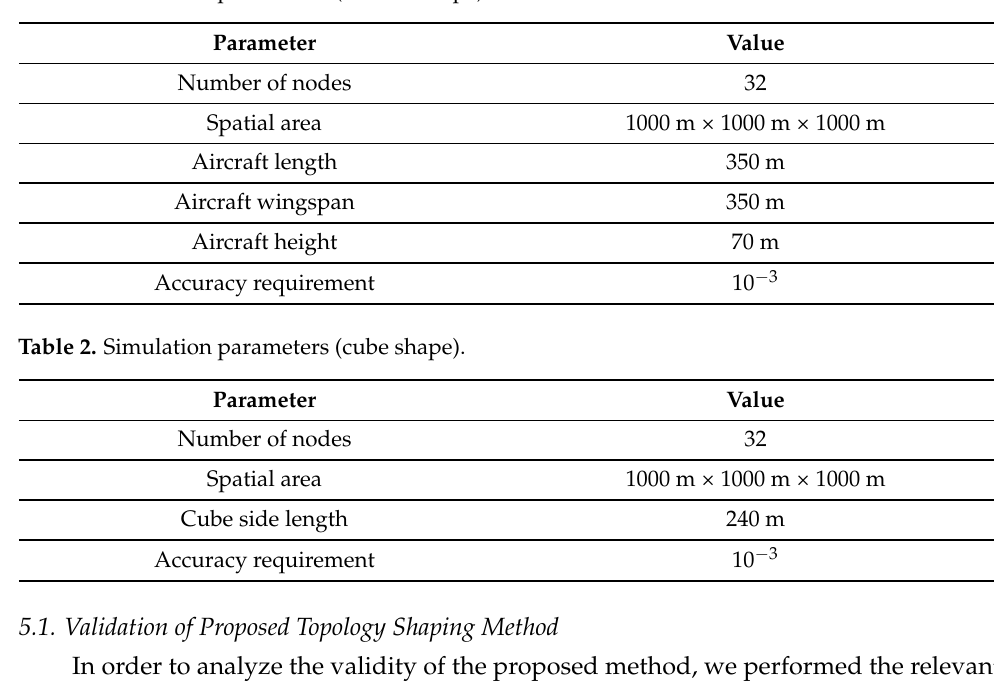
Table 1. Simulation parameters (aircraft shape).